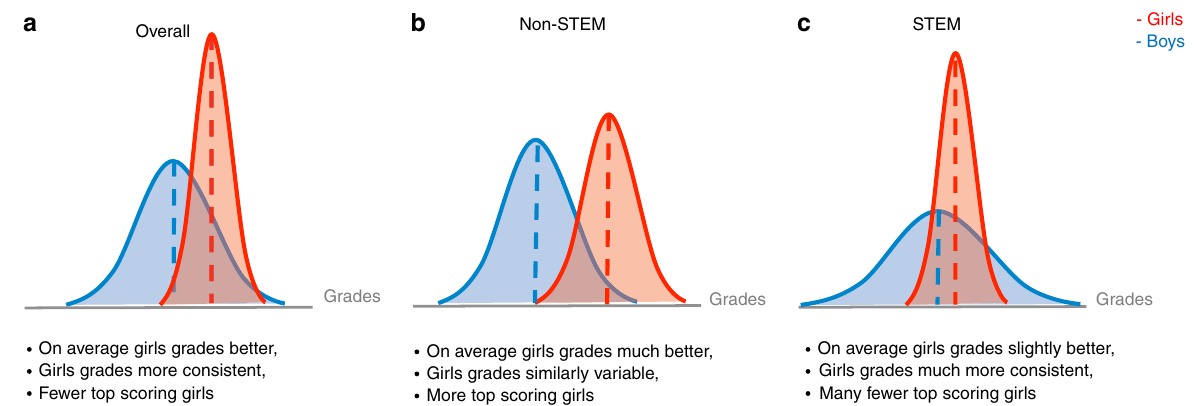
Fig. 1 Predicted distributions of school grades of girls (red) and boys (blue). a The grade distribution overlaps represent the prediction that, when all grades are considered, girls on average earn higher grades and are less variable than boys, although there are more highly performing boys than girls at the upper end of the achievement distribution. b In non-STEM subjects, the difference in mean grades between girls and boys may be even more pronounced in favour of girls, which, coupled with similar variability, should result in many more highly performing girls than boys at the upper end of the achievement distribution. c In contrast, for STEM grades, we expected less difference between boys and girls mean grades and more grade variability for boys, resulting in boys dominating at both the top and bottom of the gender similarity in variability in STEM was due to girls ’ grades being signi fi cantly more variable in STEM than non-STEM subjects (Fig. 2c, Supplementary Table 10, lnCV girls STEM – non-STEM boys ’ grades did not differ signi fi cantly between STEM and non- STEM subjects (Fig. 2c, Supplementary Table 10, lnCV boys − 0.030, CI: − 0.102 to 0.042). STEM – non-STEM diff :